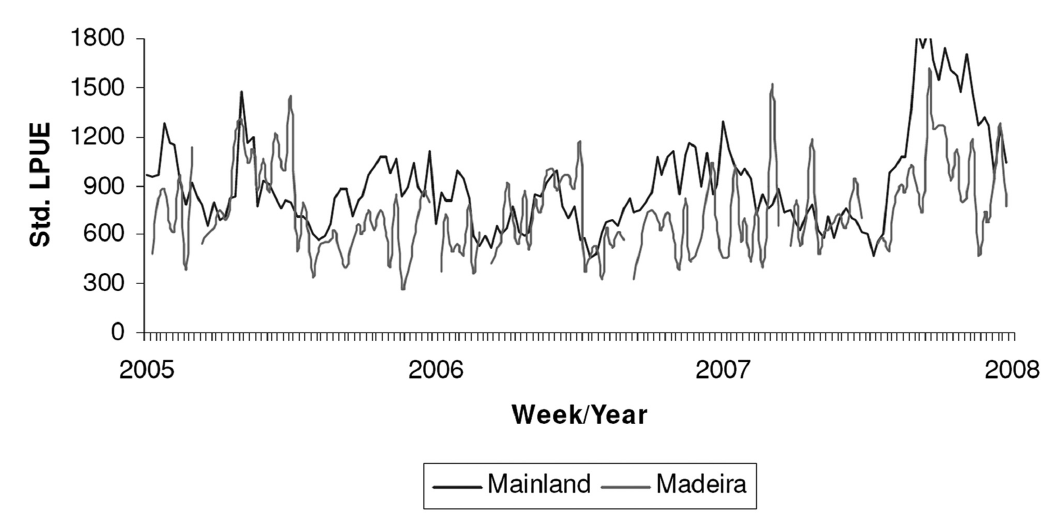
Fig . 5. – standardised weekly lPue variation in the period 2005-2007 for mainland Portugal and